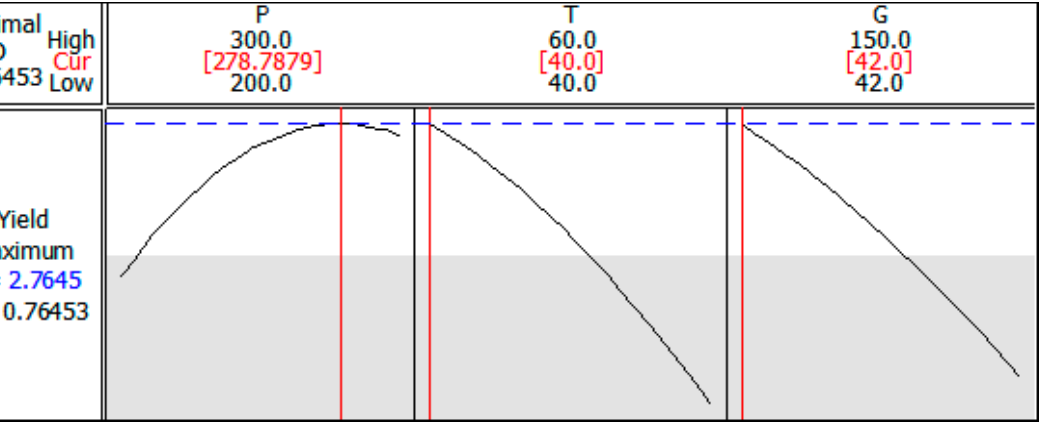
Figure 4. The yield curve for supercritical fluid extraction at 40 °C, 279 bar, and milled flower (42 mesh): mathematical models and experimental data. Table 5. Adjusted and calculated parameters for mathematical models of mass transfer.